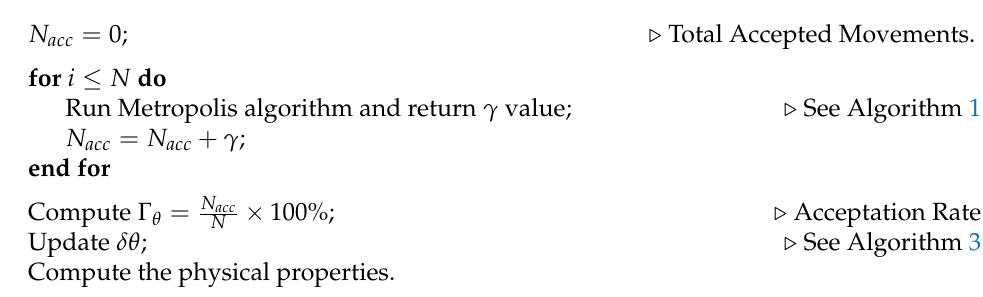
Algorithm 2 Main Algorithm.